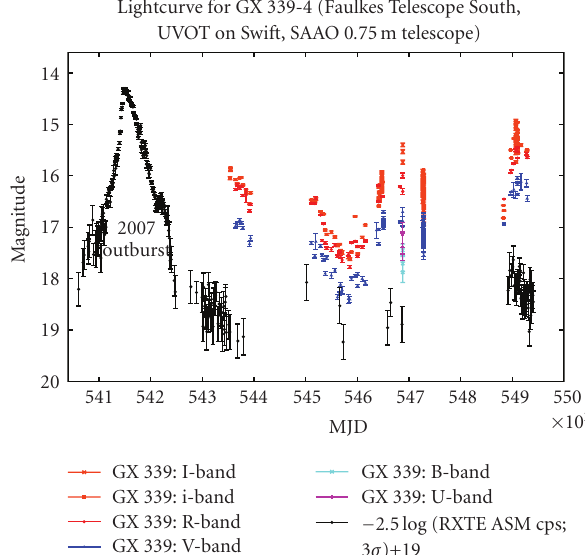
Figure 1: FT (V, R, i (cid:2) ), RXTE ASM, Swift, UVOT (U, B), and SAAO (I) band from 2007 to